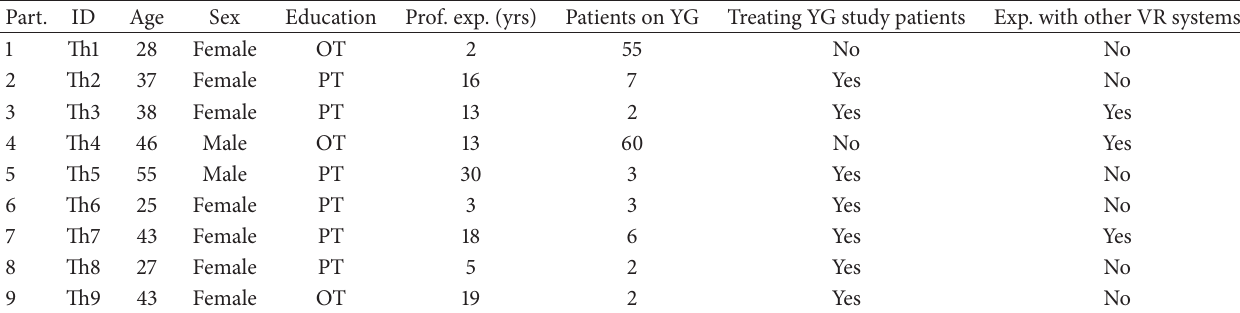
Table 2: Sociodemographic characteristics of focus group